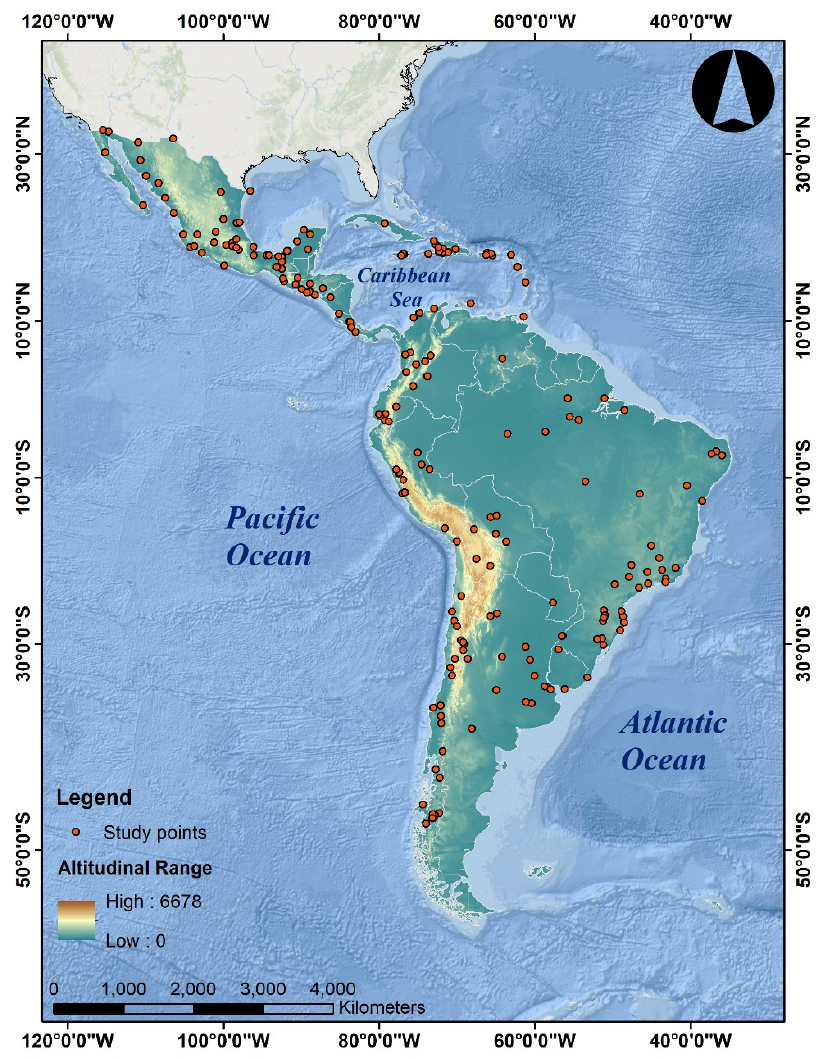
Figure 1. Spatial coverage (red dots) of LAC flood-related research papers published in WoS registered journals. Altitude in meters above sea level.